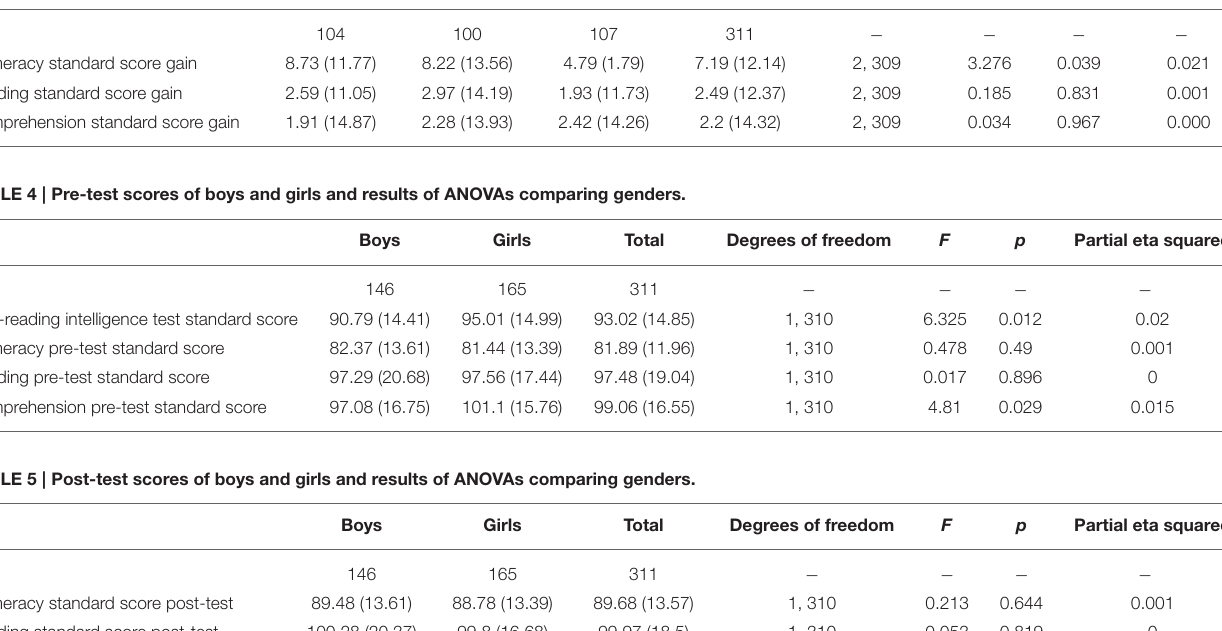
TABLE 3 | Gains in standard scores in all groups and results of ANOVAs comparing groups. Group Catch Matched Business Total Degrees F p Partial eta up time as usual of freedom squared N